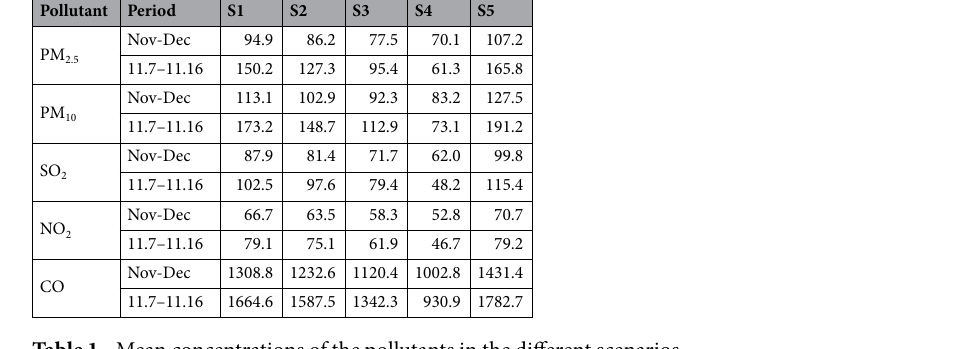
Table 1. Mean concentrations of the pollutants in the different scenarios.